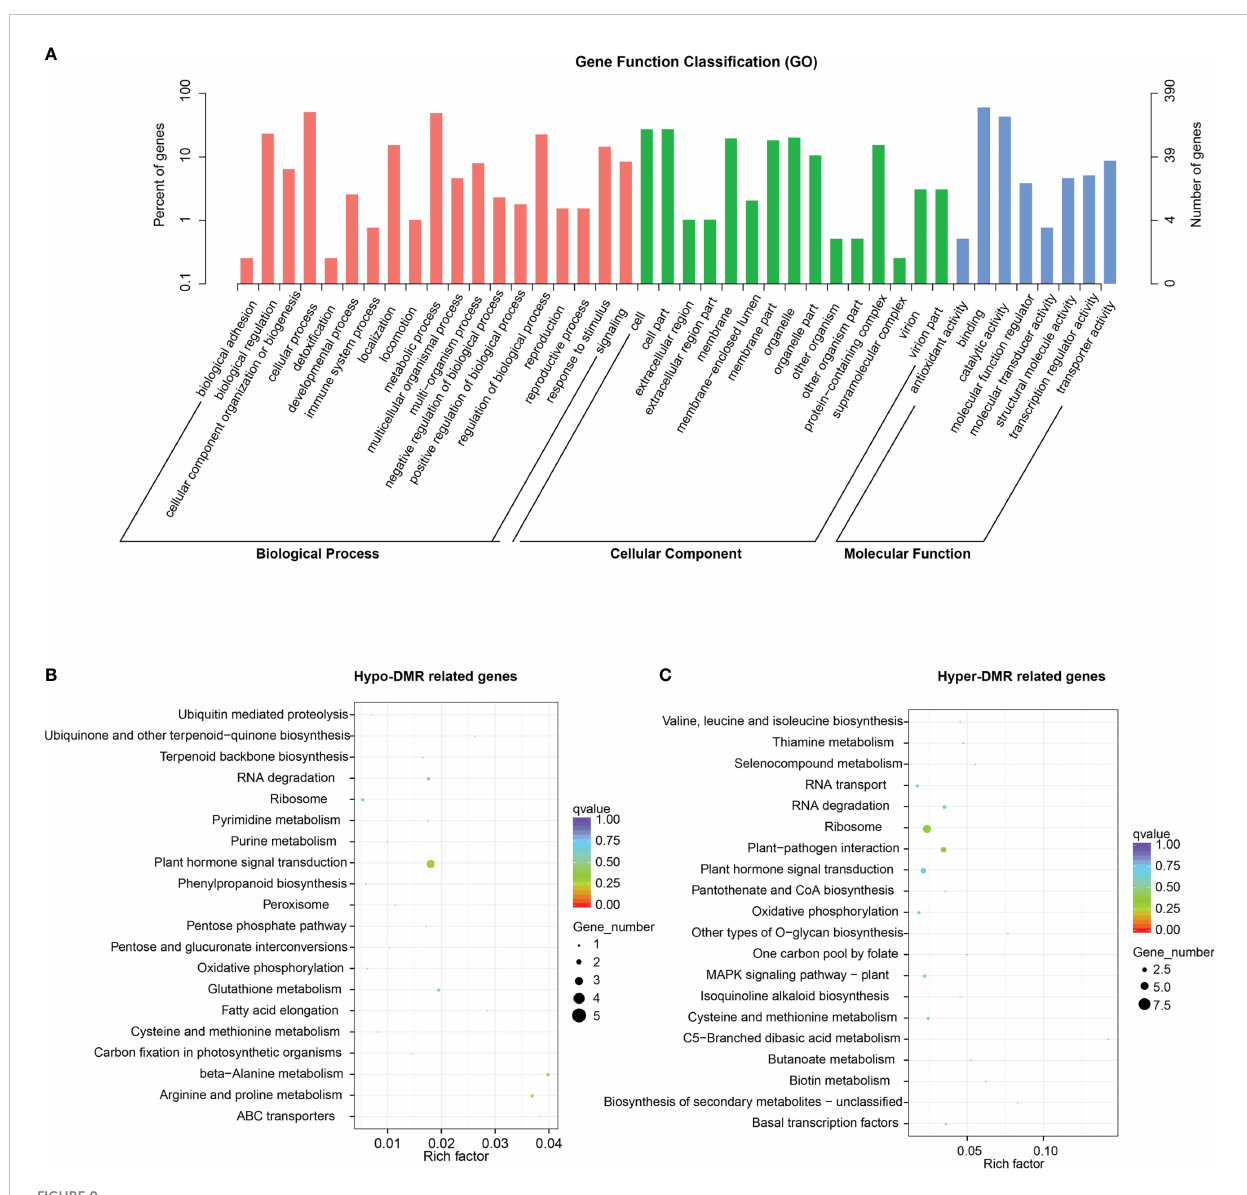
FIGURE 9 Enrichment analysis of DMR-related genes. (A) Gene ontology (GO) categories enriched in DMR-related genes. (B, C) KEGG enrichment of hypo- DMR-related genes and hyper- DMR-related